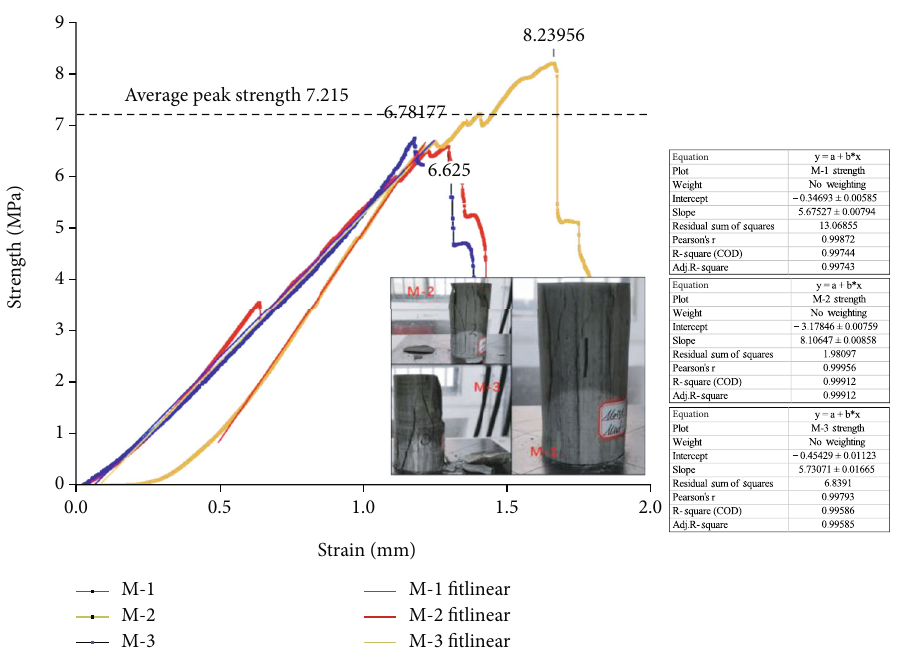
Figure 3: Failure modes and stress-strain curves of mudstone under the moist state.